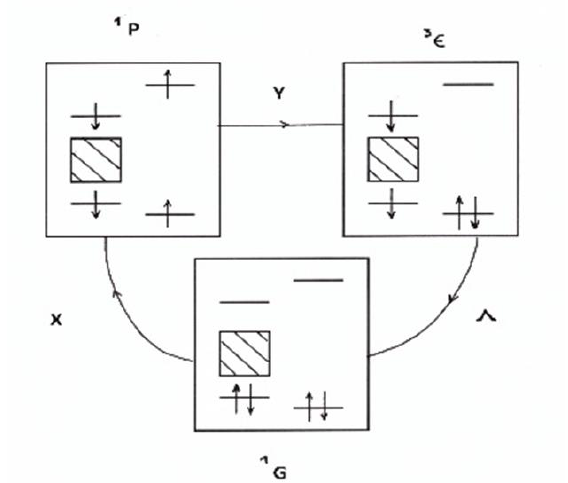
Figure 11 . A Singlet Channel: the molecule-solid electron repulsion X excites simultaneously the molecule and the solid antibonding states (a two-electron excitation). In such a neutral state the bonding (and antibonding) electrons have opposite spins and the molecule rotates differently (not represented). In the next step the molecular electrons transfer their spin momenta to the nuclei by hyperfine contact Y. Finally, the spin-orbit interaction brings back the solid to its original ground